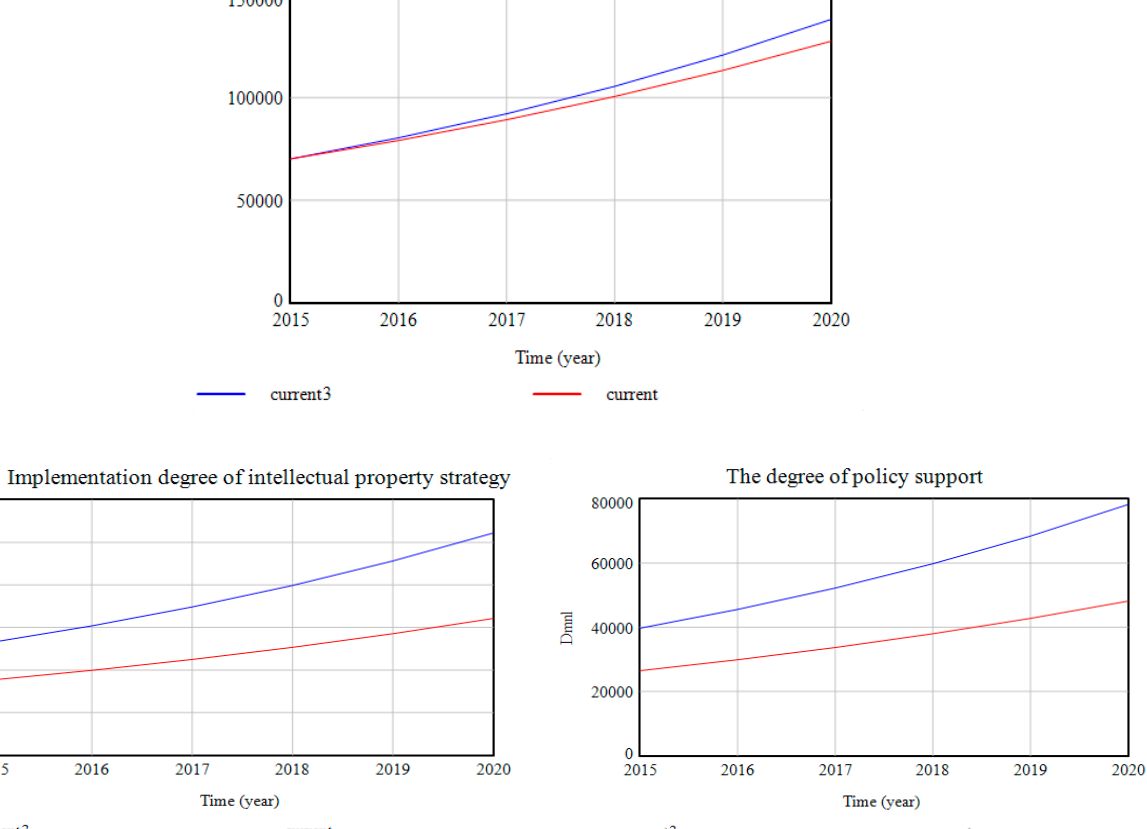
15 of 19 Figure 3. Sensitivity analysis of important indexes after constant value increased by 20%. (Note: In the above Figure 2, the horizontal axis represents the year, and the vertical axis represents the quan- tity). In addition, as can be seen from the GDP chart, the impact of new policies and stra- tegic layout had a lag effect, which can be seen from the graph with a lag time of 1–2 years, which is consistent with the cycle of public policies from introduction to implementation. Therefore, the administrative department of intellectual property rights should combine the regional economic situation, early layout, and early planning as soon as possible to